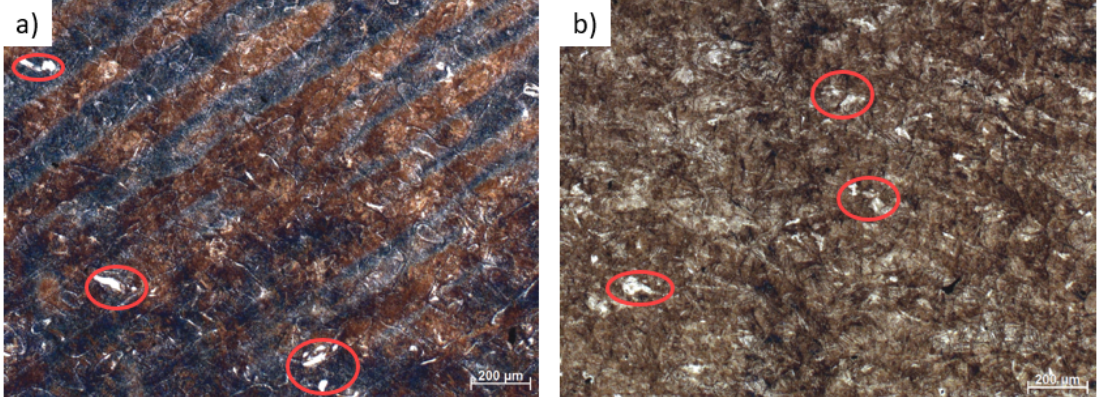
Figure 4. Microstructure of additive manufactured H13 tool steel show martensite structure with retained austenite (red circles): ( a ) perpendicular to built direction, ( b ) parallel to built